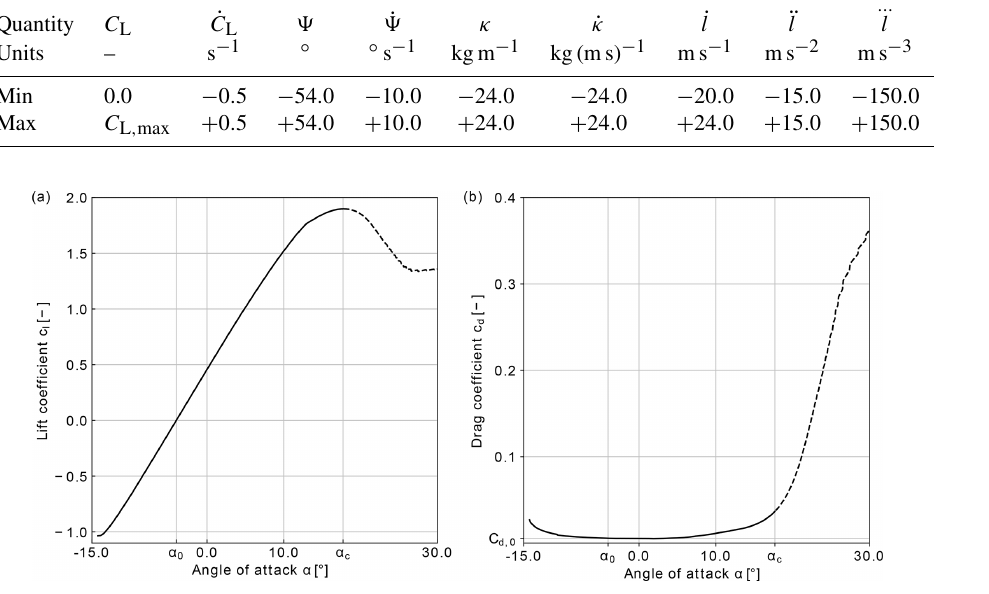
Figure 4. Aerodynamic polars of the SD 7032 airfoil generated at a chord-based Reynolds number Re c = 10 7 with XFLR5: (a) lift coefficient polar and (b) drag coefficient polar. The dashed lines show the coefficient values past the critical angle of attack α c ≈ 17 . 7 ◦ . The zero-lift angle of attack of the airfoil is α L = 0 ≈ − 4 . 0 ◦ while the profile drag coefficient is C d , 0 = 0 .